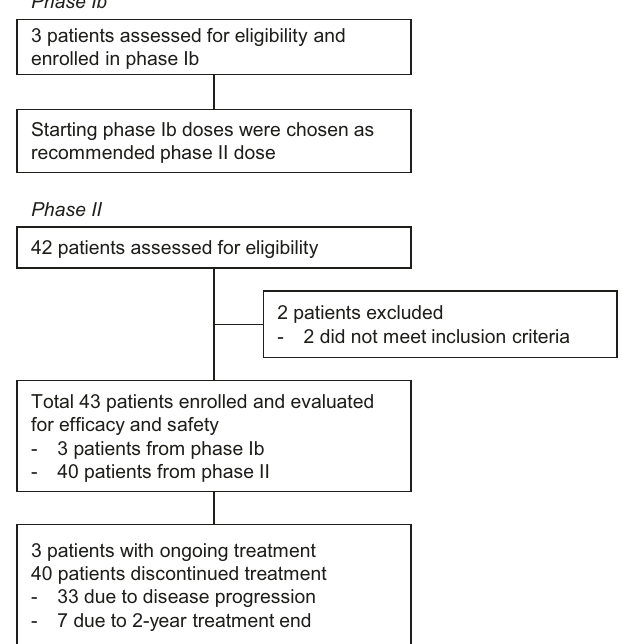
Fig. 1 | Trial pro fi le. Diagram indicating participant numbers and disposition through the course of the trial.